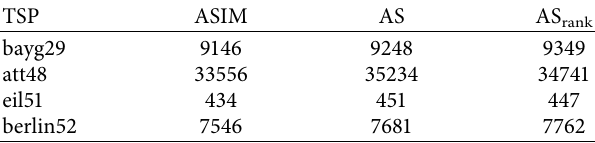
Table 4: The best solution in 20 trials. TSP ASIM AS AS rank bayg29 9140 9195 9233 att48 33549 35090 34106 eil51 431 443 438 berlin52 7544 7664 7549 Table 5: The average of the best solutions in 20 trials. TSP ASIM AS AS rank bayg29 9146 9248 9349 att48 33556 35234 34741 eil51 434 451 447 berlin52 7546 7681